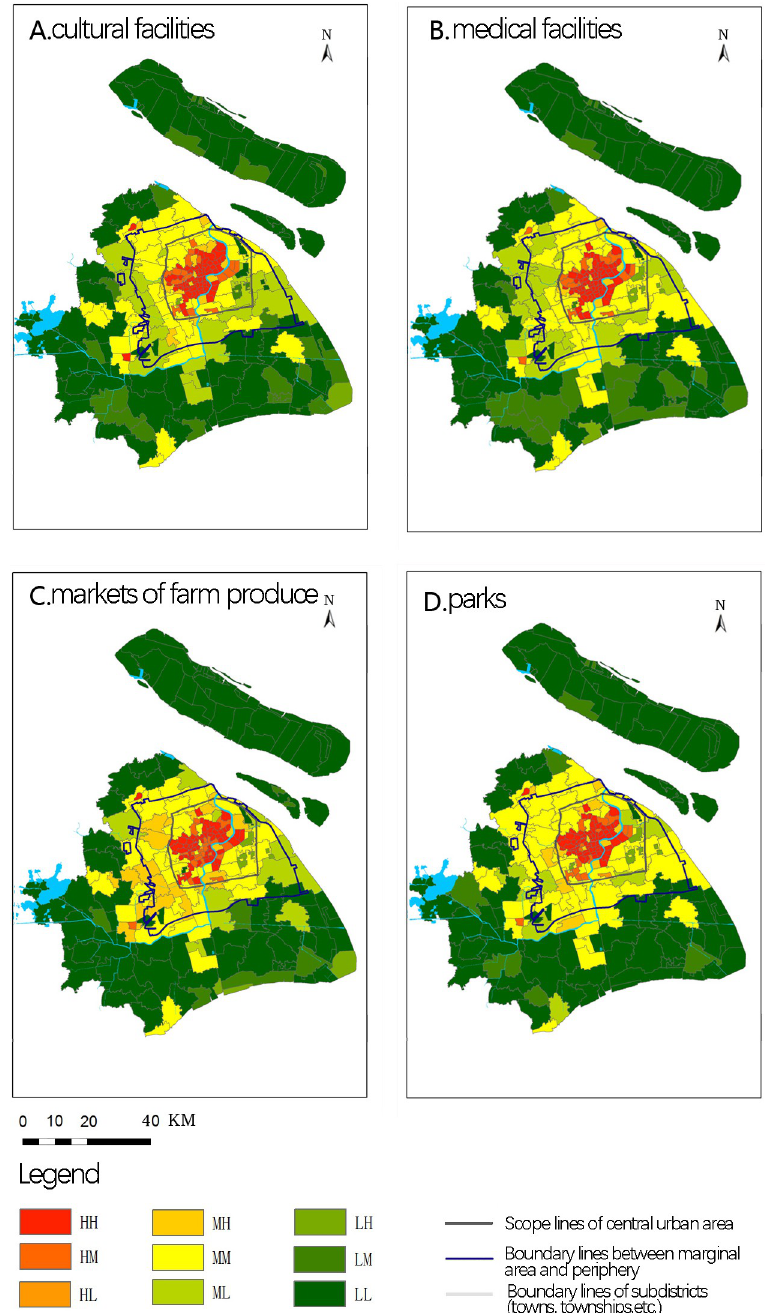
Fig 4. The spatial pattern of matching values between population density and the accessibility of various facilities. Source: Created by the author based on the base map of Shanghai from the Open Street Map(OSM) geographic data platform(https://www.openstreetmap.org/).